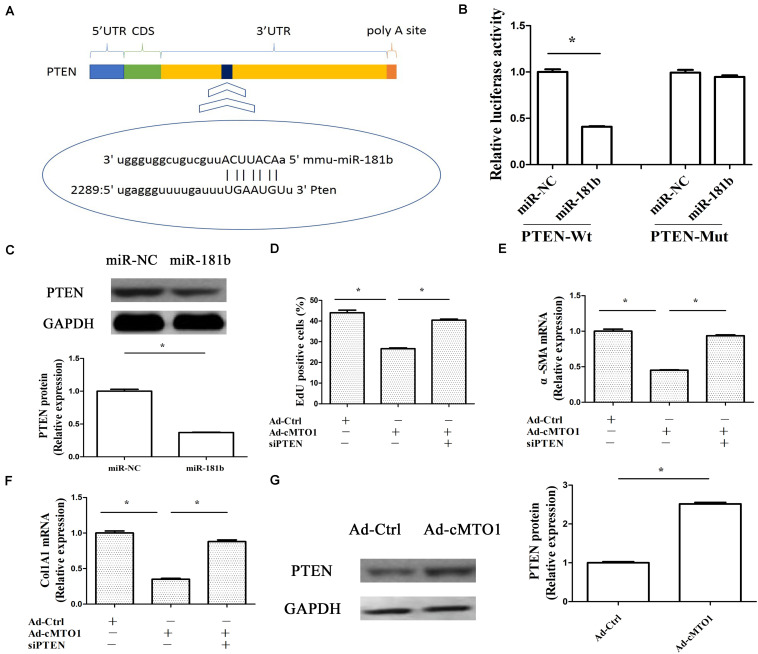
Anti-fibrotic roles of cMTO1 in HSCs were via miR-181b/PTEN axis. Primary 1-day-old HSCs were transduced with Ad-cMTO1 for 48 h and transfected with PTEN siRNA for additional 48 h. (A) A schematic drawing indicated the putative binding sites of miR-181b-5p with respect to PTEN. (B) Relative luciferase activities of PTEN-Wt or PTEN-Mut were analyzed in HEK-293T cells. (C) PTEN protein in miR-181b-transfected cells. (D) Cell proliferation down-regulated by cMTO1 was restored by PTEN siRNA. (E,F) Loss of PTEN inhibited cMTO1-reduced α-SMA and Col1A1. (G) PTEN protein in cMTO1-overexpressing cells. *P < 0.05. Each value is the mean ± SD of three experiments.